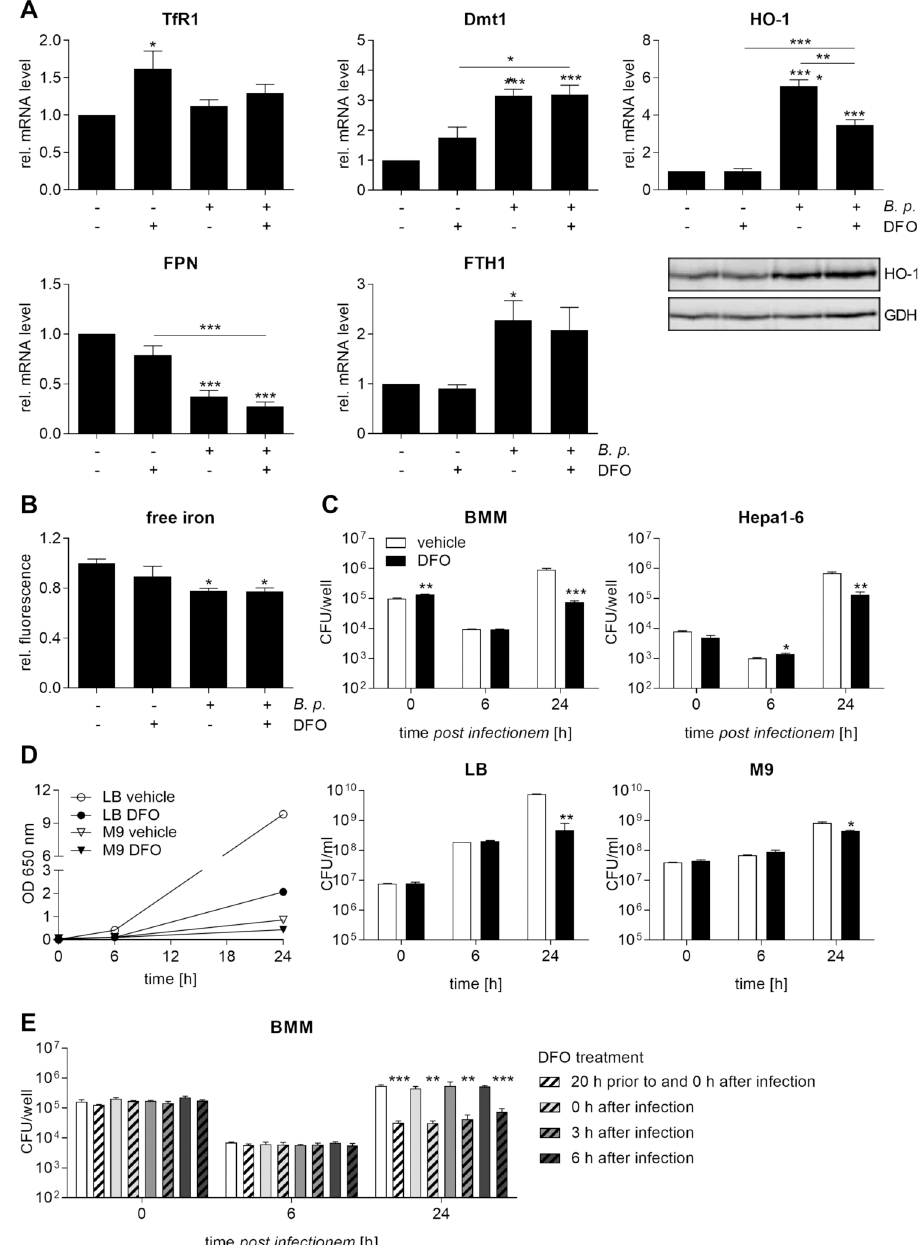
Fig 5. Iron chelation limits intracellular B . pseudomallei growth by direct bacteriostatic properties. BMM were treated with deferoxamine (DFO, 50 μM) or corresponding vehicle (A. bidest) for 20 hours followed by infection with B . pseudomallei at MOI 50. (A) 24 hours after infection gene expression of TfR1 (n = 8), Dmt1 (n = 8), HO-1 (n = 6), FPN (n = 6), and FTH1 (n = 5) was analysed by qRT-PCR. Expression of HO-1 was detected by immunoblot in cell lysates. Data are expressed as mean with SEM. (B) Intracellular free iron levels were determined after 24 hours using the iron- sensitive fluorescent probe Phen Green SK. Data are presented as mean with SEM of triplicate determinations (n = 3). (A, B) Comparison of groups was done using one-way ANOVA and the Bonferroni post-hoc test ( (cid:3) p < 0.05, (cid:3)(cid:3) p < 0.01, (cid:3)(cid:3)(cid:3) p < 0.001). (C) BMM or murine hepatoma Hepa1-6 cells were treated with DFO (50 μM) or corresponding vehicle for 20 hours followed by infection with B . pseudomallei at MOI 50 (BMM) or MOI 200 (Hepa1-6). Invasion (0 h) and intracellular growth (6 h, 24 h) of B . pseudomallei were examined by kanamycin protection assay. Data are shown as mean with SEM of triplicate determinations (BMM, n = 3; Hepa1-6, n = 4). Statistical analyses were done using Student’s t- test( (cid:3) p < 0.05, (cid:3)(cid:3) p < 0.01, (cid:3)(cid:3)(cid:3) p < 0.001). (D) LB broth or M9 minimal medium with or without DFO (50 μM) or corresponding vehicle was inoculated with B . pseudomallei . The optical density (OD) at 650 nm and colony